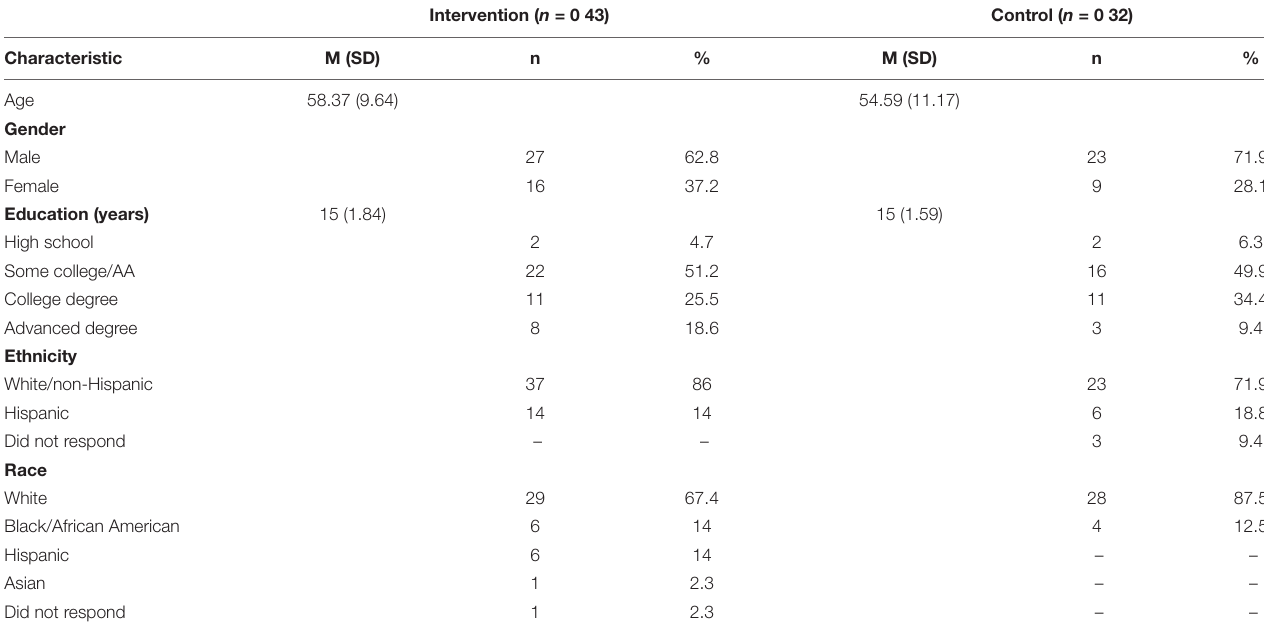
TABLE 2 | Sample characteristics of Veterans participating in this